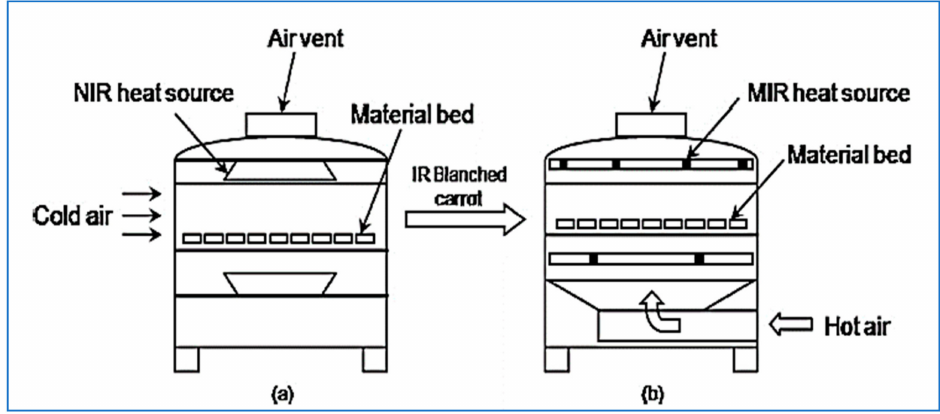
Figure 9. Schematic diagram of IR blanching ( a ) and hybrid drying ( b ) system